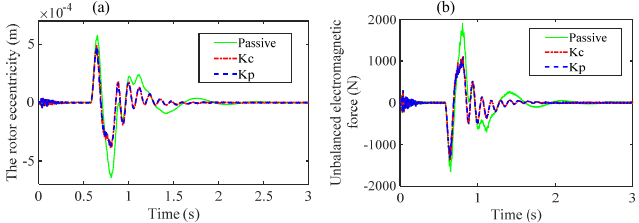
Figure 10. The motor responses under bump excitation: ( a ) the rotor eccentricity; ( b ) the UEF.